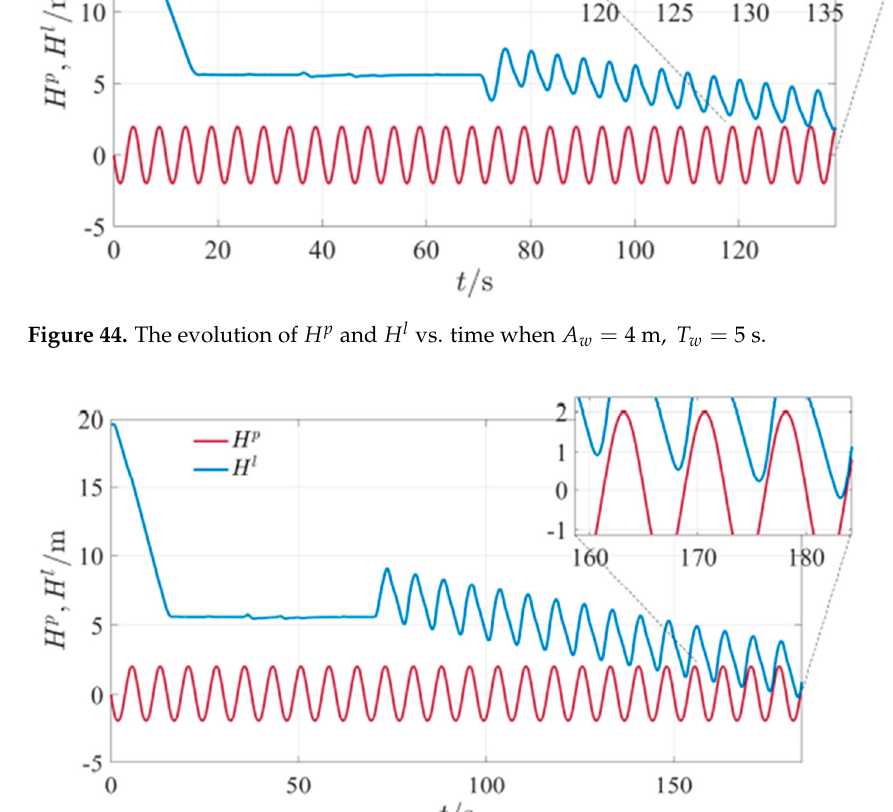
Figure 45. The evolution of p H and l H vs. time when 4 , 7.5